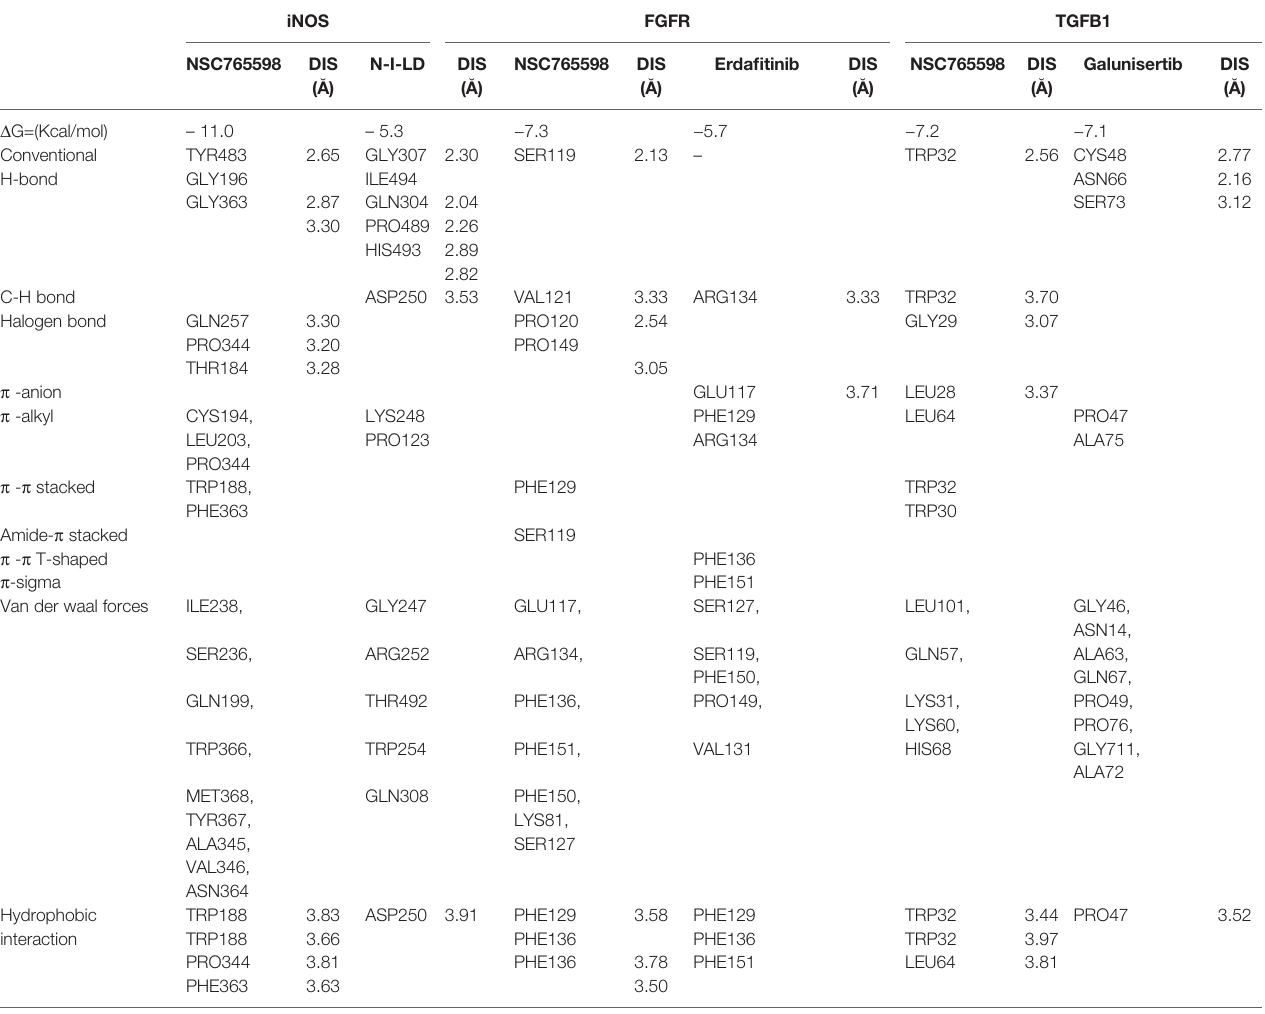
p -sulfur, p -electroncloudbetweentheAromaticringsofligandsandlonepairofelectroncloudofsulfuratominthereceptors; p - p stacked: p -electroncloudbetweentheAromaticrings, p - p T-shaped: T shaped p -electron cloud between the Aromatic rings, p -alkyl; p -electron cloud between the aromatic ring of ligand and alkyl group of the receptor, N-I-LD, N-Iminoethyl- L - lysine